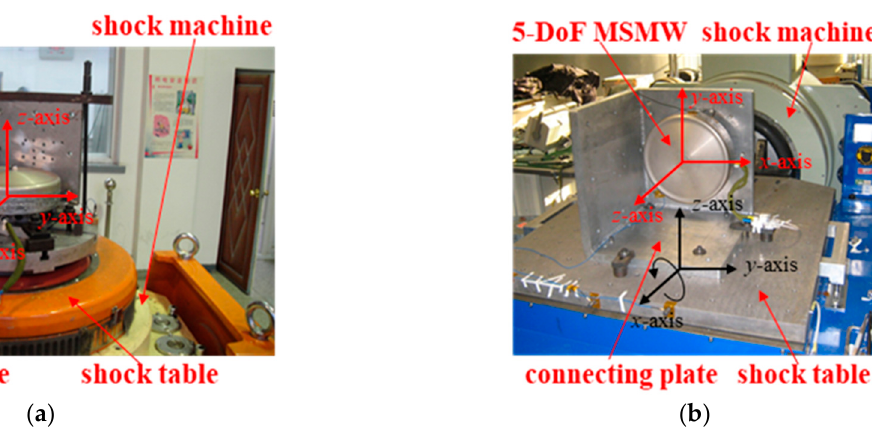
Figure 8. The vibration experimental systems of the 5 ‐ DoF MSMW. ( a ) The translational vibration system of the 5 ‐ DoF MSMW. ( b ) The torsional vibration system of the 5 ‐ DoF MSMW.